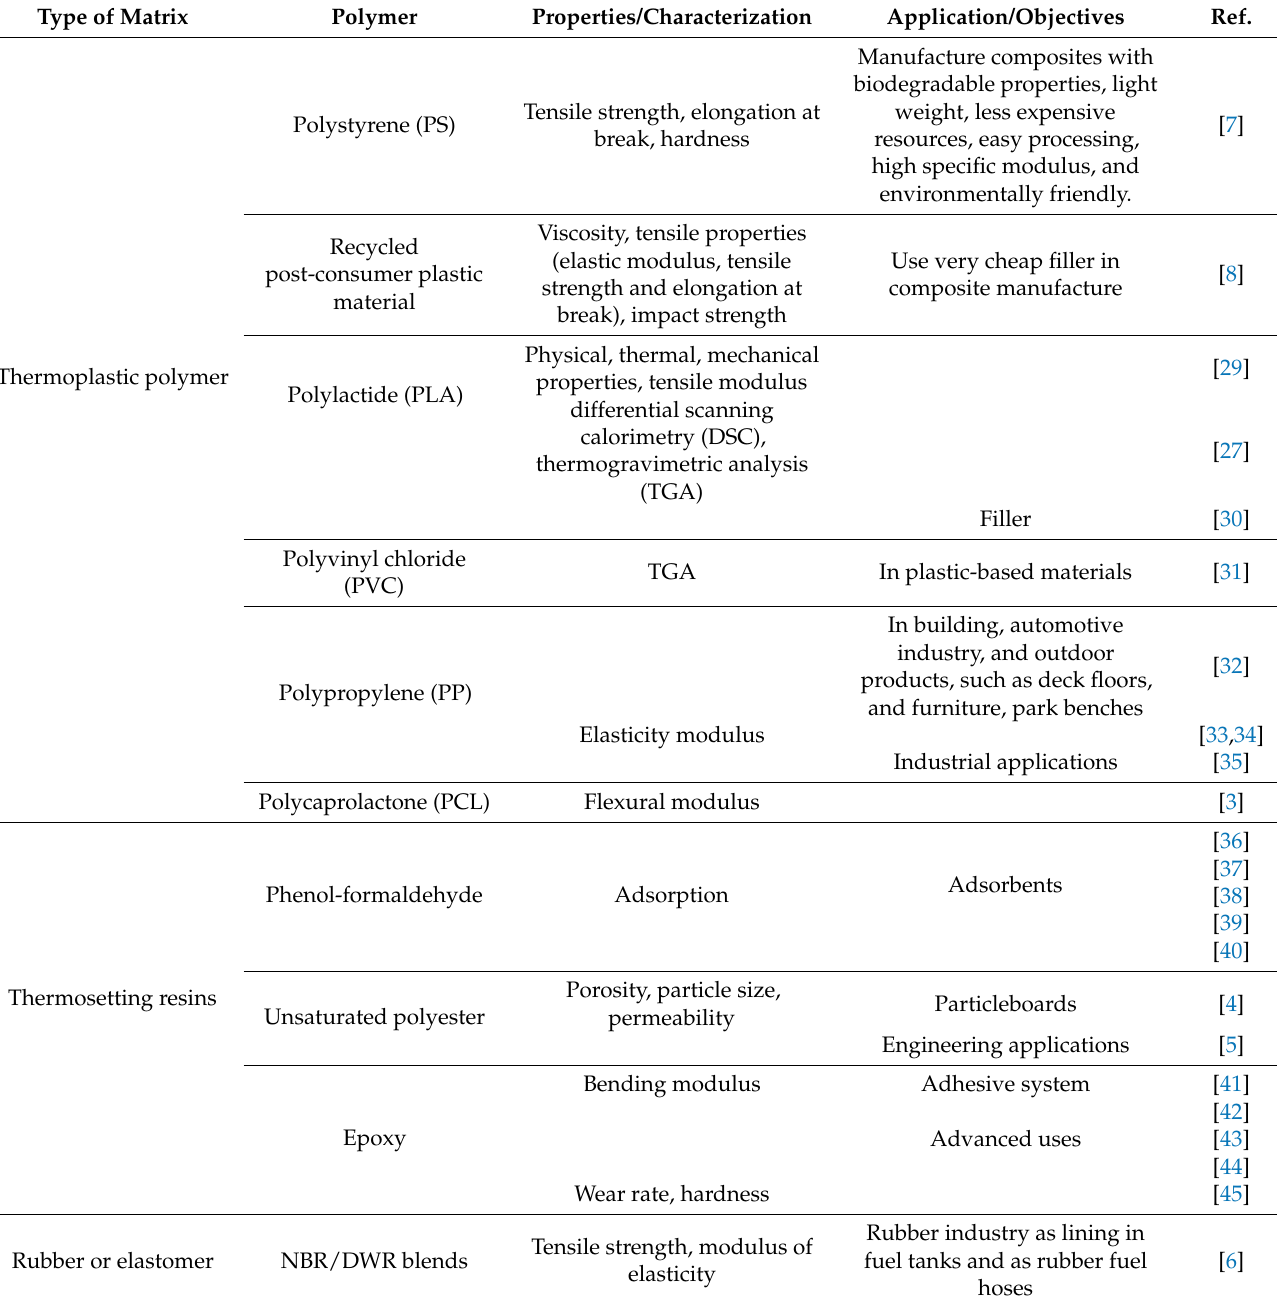
Table 3. Type of polymer matrix, polymers, properties, characterization, and potential applications or objectives of the